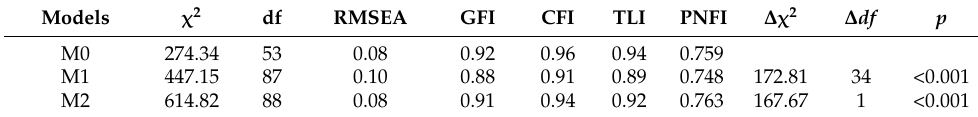
Table 2. Fit index for structural equation models.